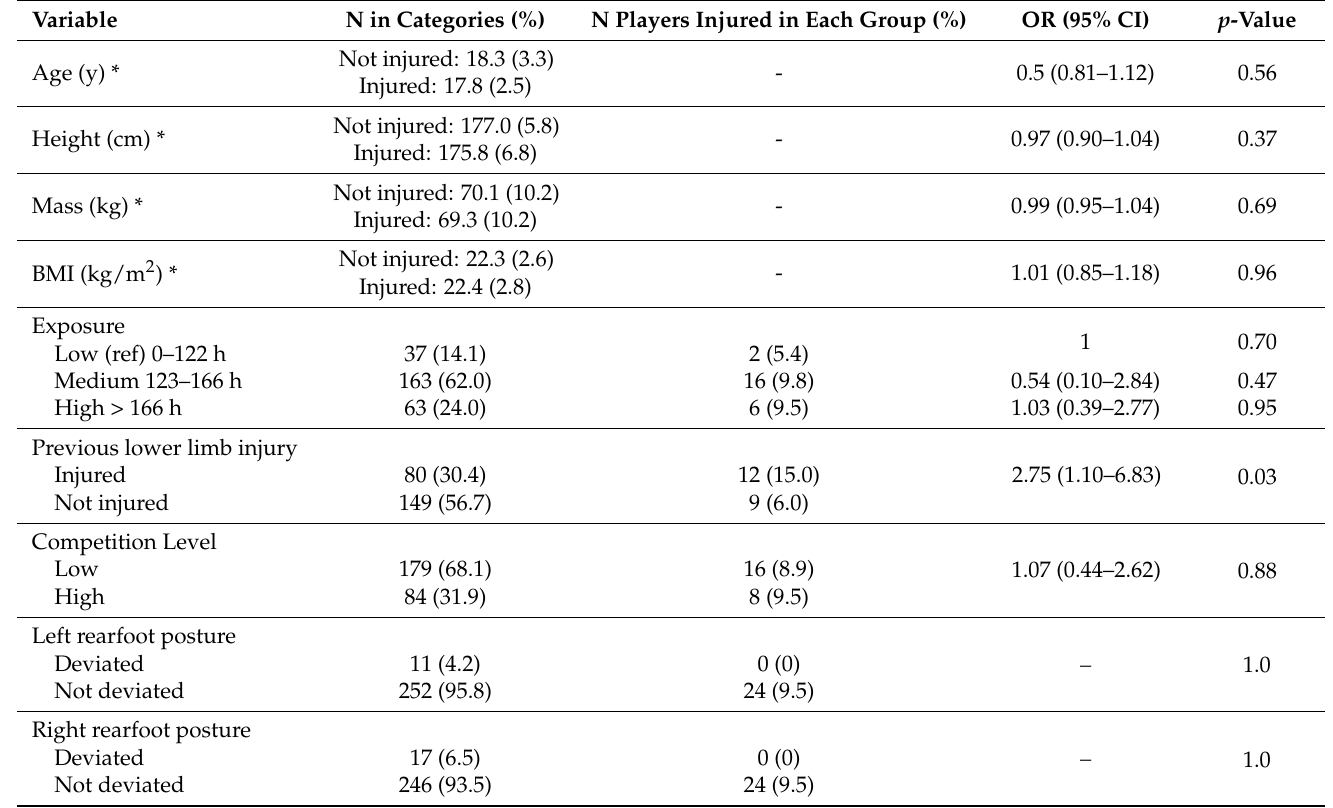
Table 5. Univariate regression analysis for factors potentially associated with in-season lower limb non-contact injuries in football players ( n = 263), with descriptive statistics for each variable